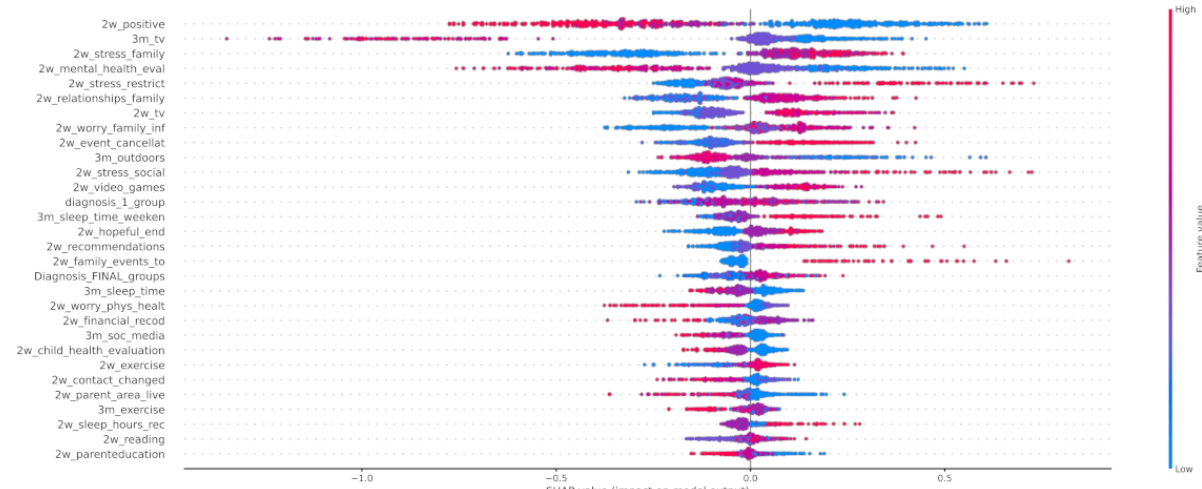
Figure 15. SHAP values of patients from class 2.